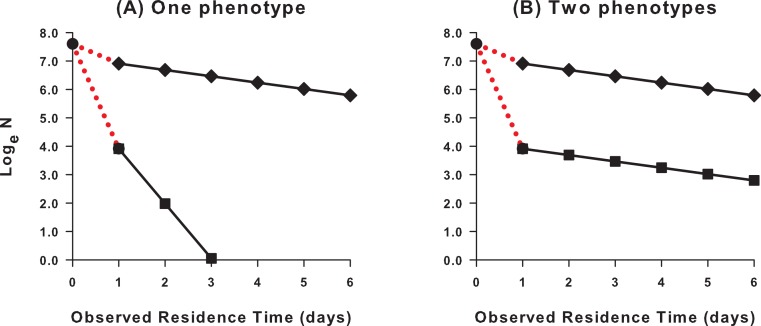
Hypothetical residence plots showing alternative explanations for a low number of recaptures.The zero day data point is the number of specimens initially captured and released, and the day 1 data point is the number of specimens recaptured at least once; red dotted lines indicate the number of specimens never recaptured. If the residence-rate of the average phenotype is high (gradient of regression line shallow), specimens will remain in the population for a long time and a high number of recaptures is predicted (top line, diamonds). If the observed number of recaptures are low, there are two possibilities. (A) The residence-rate of the average phenotype has declined (gradient of regression line steep), so specimens rapidly exit the population and avoid recapture (bottom line, squares). (B) A second phenotype has appeared in the population with a very high death/emigration rate; these avoid recapture and do not impact on the calculated residence-rate of the average phenotype (gradient of regression line unchanged; bottom line, squares), but their presence can be deduced if the number of recaptures is significantly lower than would be predicted with the residence-rate of the average phenotype.